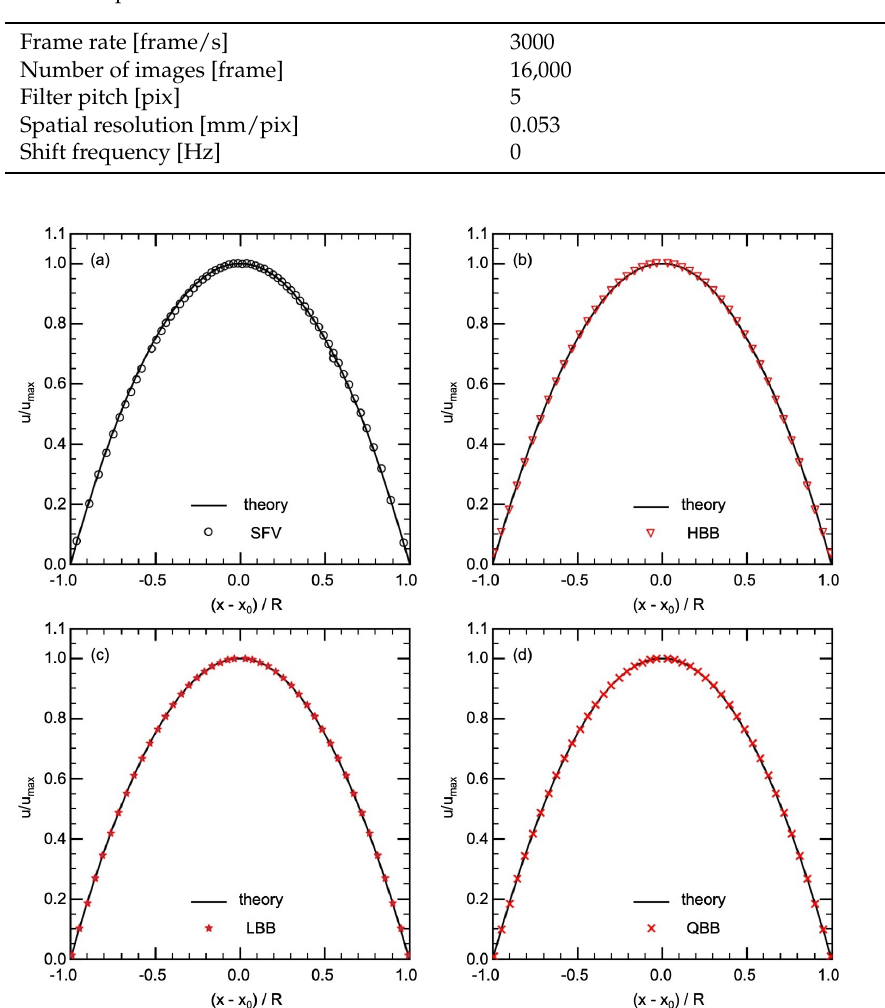
Figure 6. Comparison of velocity in pipe flow between theory and ( a ) SFV, ( b ) HBB, ( c ) LBB, ( d ) QBB ( x is the position of the velocity data, x 0 is the position of the center of the pipe and R is the radius of the pipe).